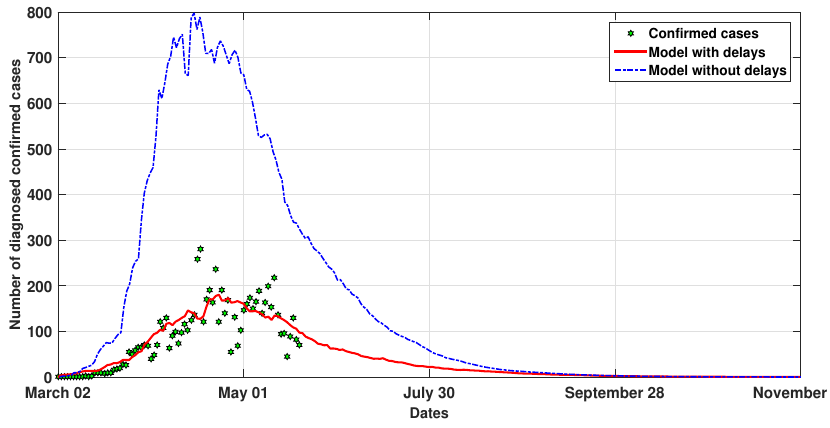
Figure 2. Effect of delays on the diagnosed confirmed cases.